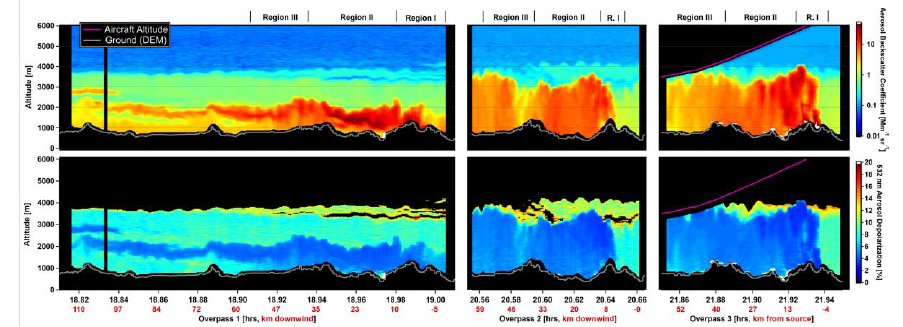
Figure 6. DIAL-HSRL nadir retrievals of 532 nm aerosol backscatter coefficient ( top row ) and depolarization ratio ( bottom row ) for the three longitudinal overpasses (L1-L3). During the MISR/MINX overpass (L1), the plume is less vertically developed and only reaches an altitude of approximately 2 km, consistent with the MISR/MINX retrievals shown in Figure 2. The anomalous high-scattering values very near the surface at ~[18.97, 20.66, and 21.88 – 21.92 hrs] are scattering contamination from the ground surface and should not be interpreted as aerosol signal. Note: Time is in UTC .